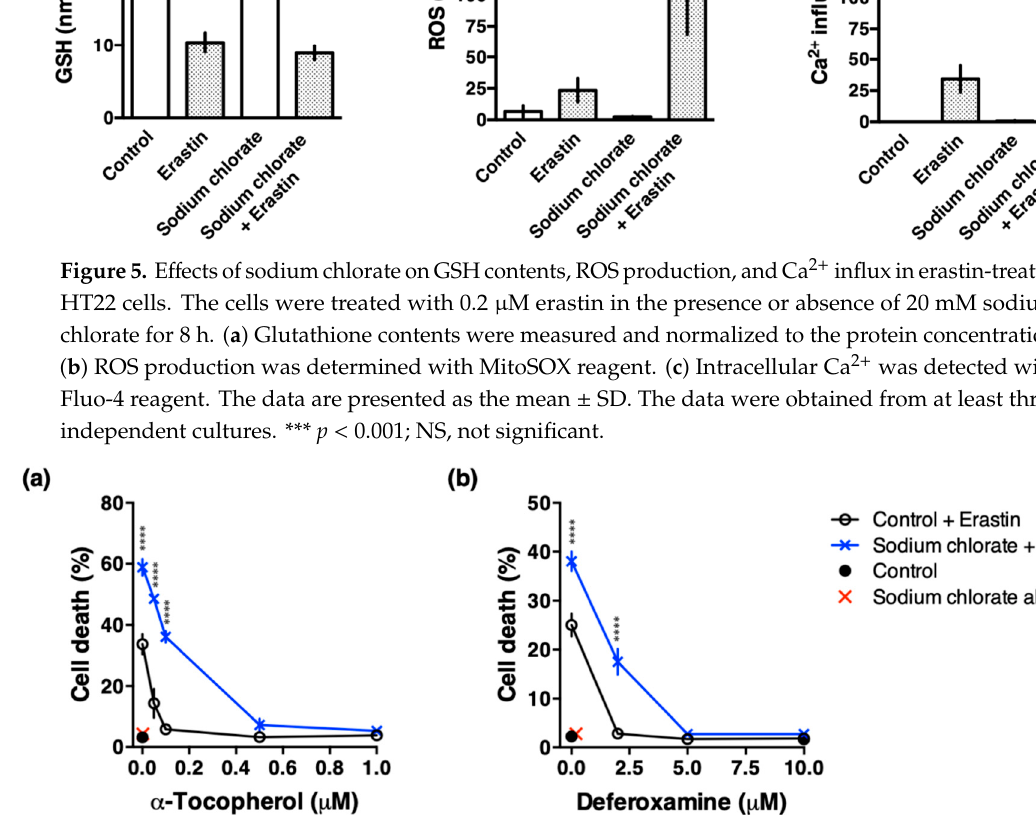
Figure 5. Effects of sodium chlorate on GSH contents, ROS production, and Ca 2+ influx in erastin- treated HT22 cells. The cells were treated with 0.2 µM erastin in the presence or absence of 20 mM sodium chlorate for 8 h. ( a ) Glutathione contents were measured and normalized to the protein concentration. ( b ) ROS production was determined with MitoSOX reagent. ( c ) Intracellular Ca 2+ was detected with Fluo-4 reagent. The data are presented as the mean ± SD. The data were obtained from at least three independent cultures. *** p < 0.001; NS, not significant.